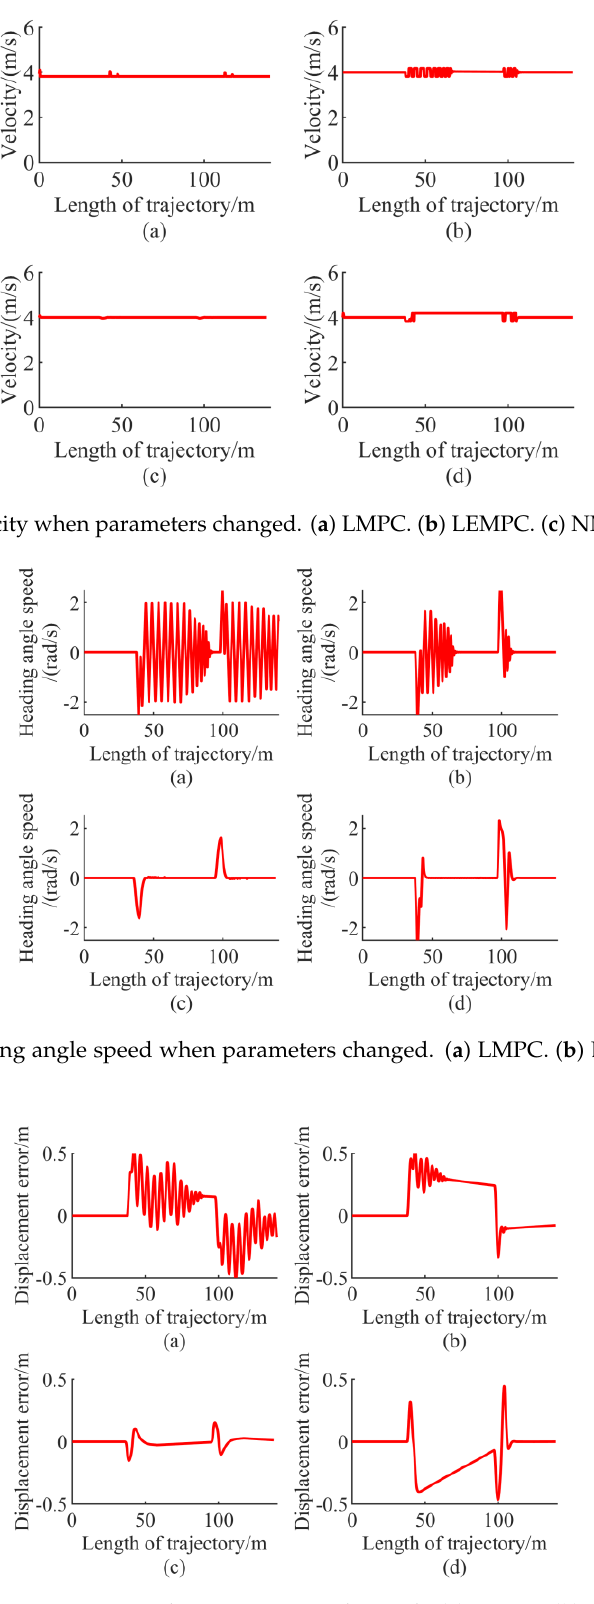
Figure 25. The heading error when parameters changed. ( a ) LMPC. ( b ) LEMPC. ( c ) NMPC. ( d ) NEMPC.